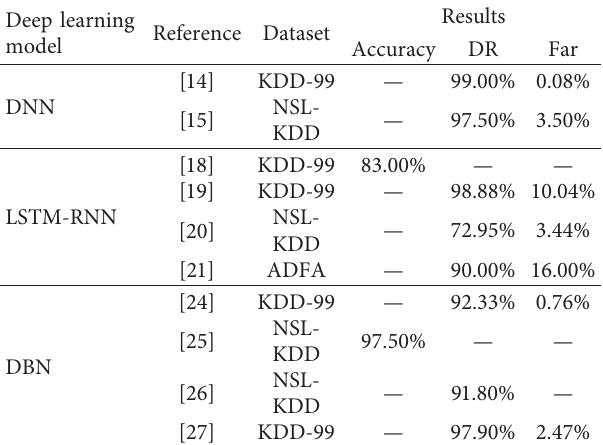
Table 1: Summary of test results for different depth